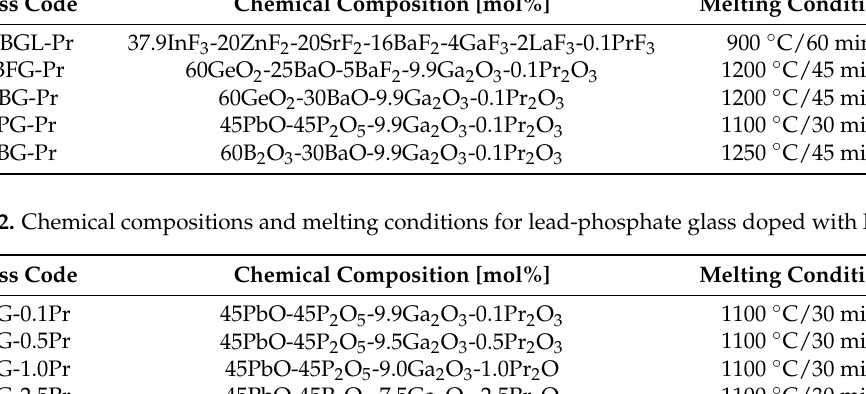
Table 1. Chemical compositions and melting conditions for inorganic glasses doped with Pr 3+ . Glass Code